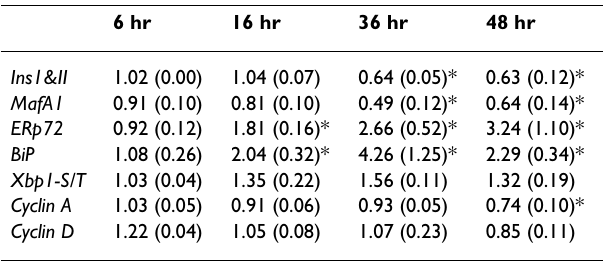
Table 1: Temporal Changes in gene expression following Perk ablation in 832/13 cells